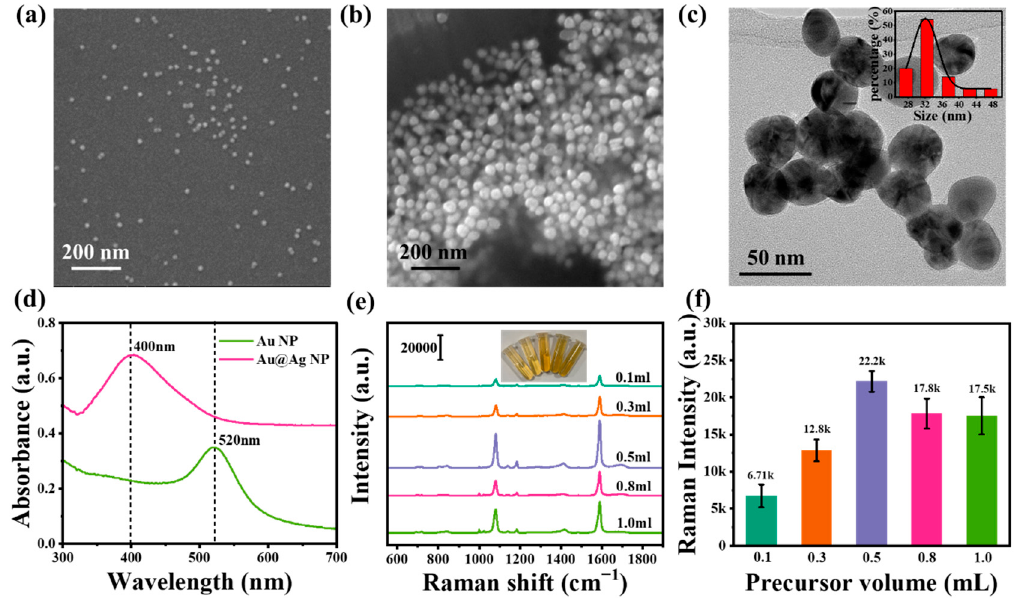
Figure 2. ( a ) SEM image of Au NSs; ( b ) SEM image of Au@Ag NSs in 0.5 mL AgNO 3 ; ( c ) HRTEM image of Au@Ag NSs in 0.5 mL AgNO 3 , with inset showing data from the statistical analysis of Au@Ag NSs size (fitted with a Gaussian distribution); ( d ) UV-vis spectra of Au NSs and Au@Ag NSs; ( e ) Raman spectra of 60 mM 4-MBA on Au@Ag with different volumes of AgNO 3 (from 0.1 mL to 1.0 mL); ( f ) histogram of the standard error statistics of Raman intensity as the volume of AgNO 3 was increased from 0.1 mL to 1.0 mL.